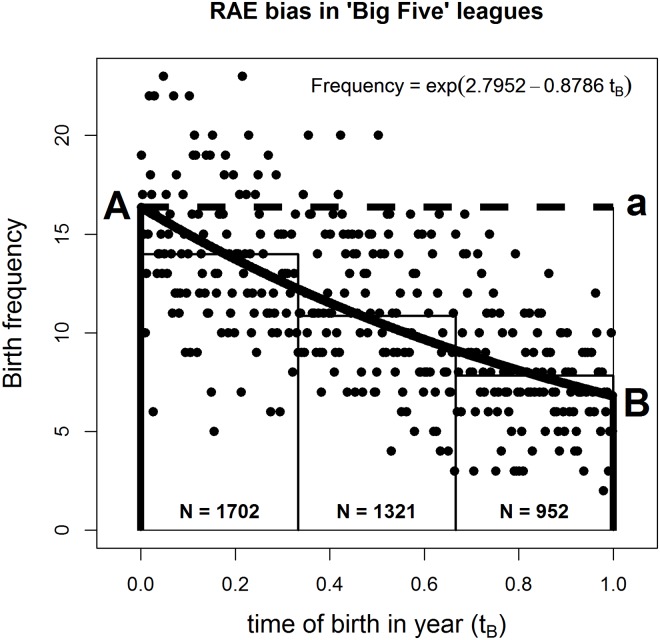
Poisson regression curve with tercile frequencies shown as bars.